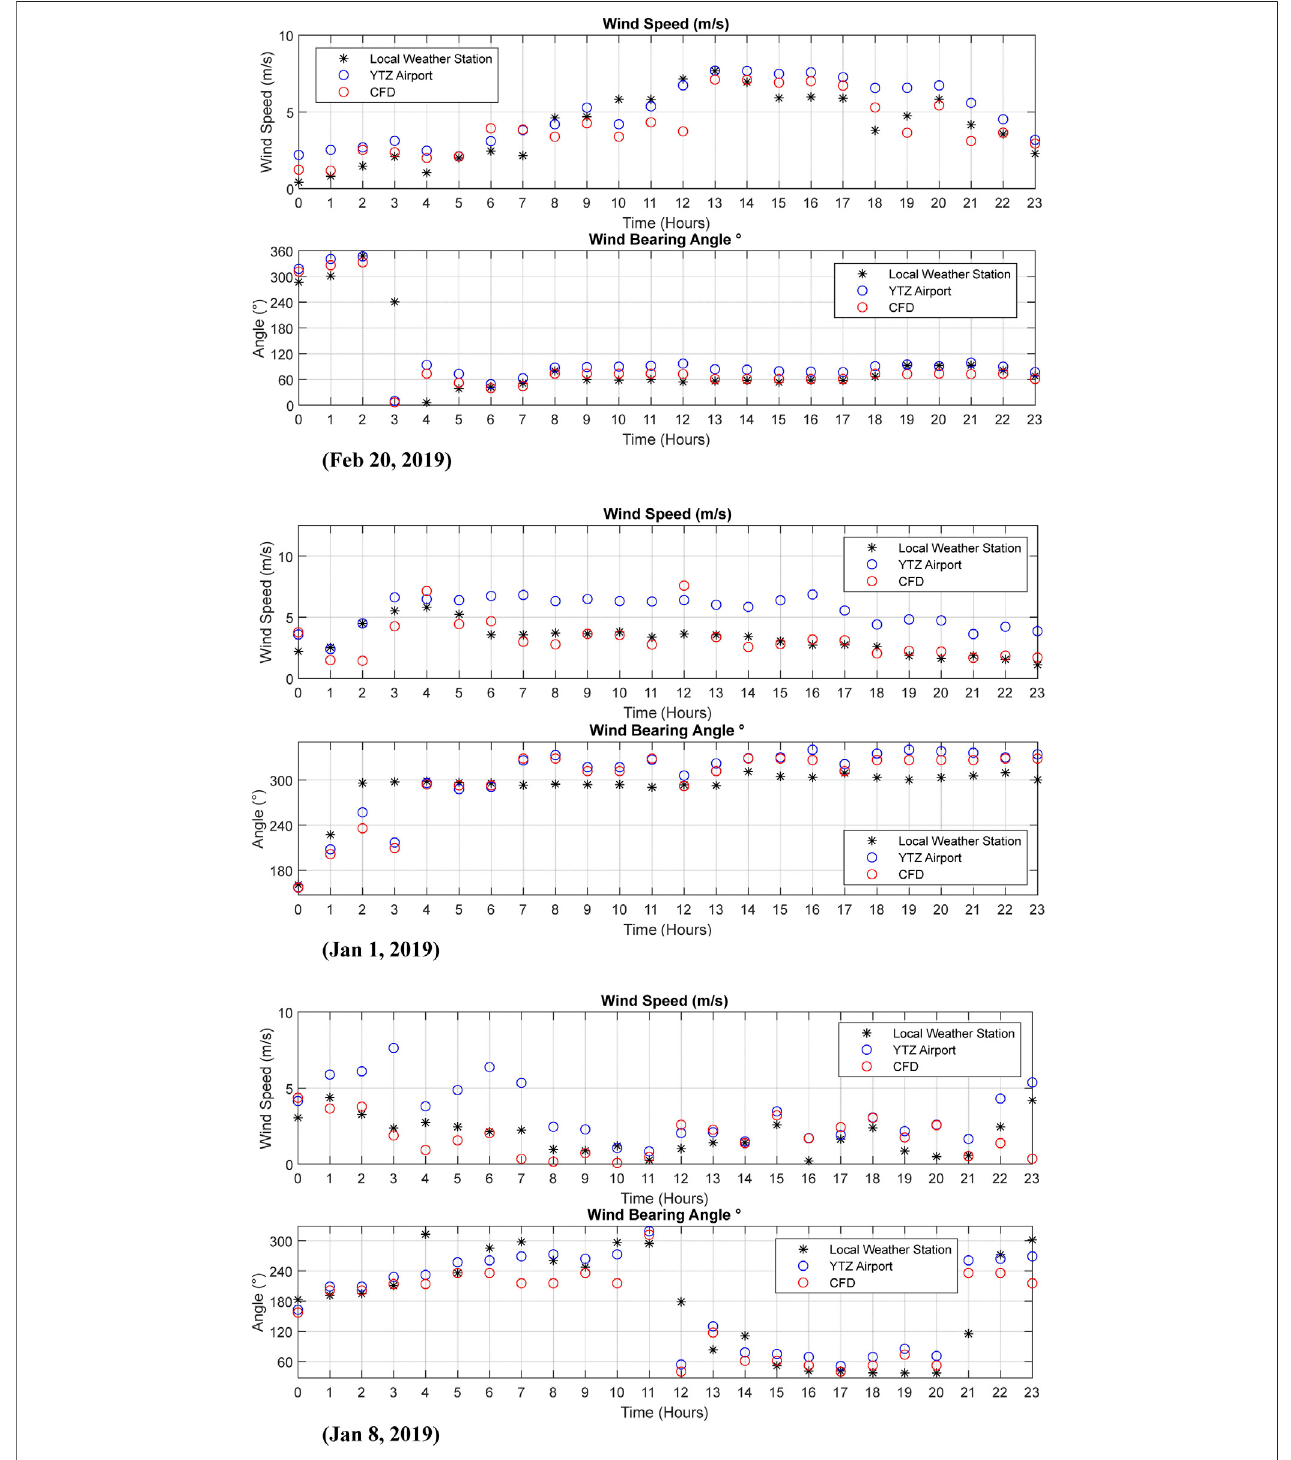
FIGURE 8 | Validation of weather data with the TAO (Jan 08, 2019).